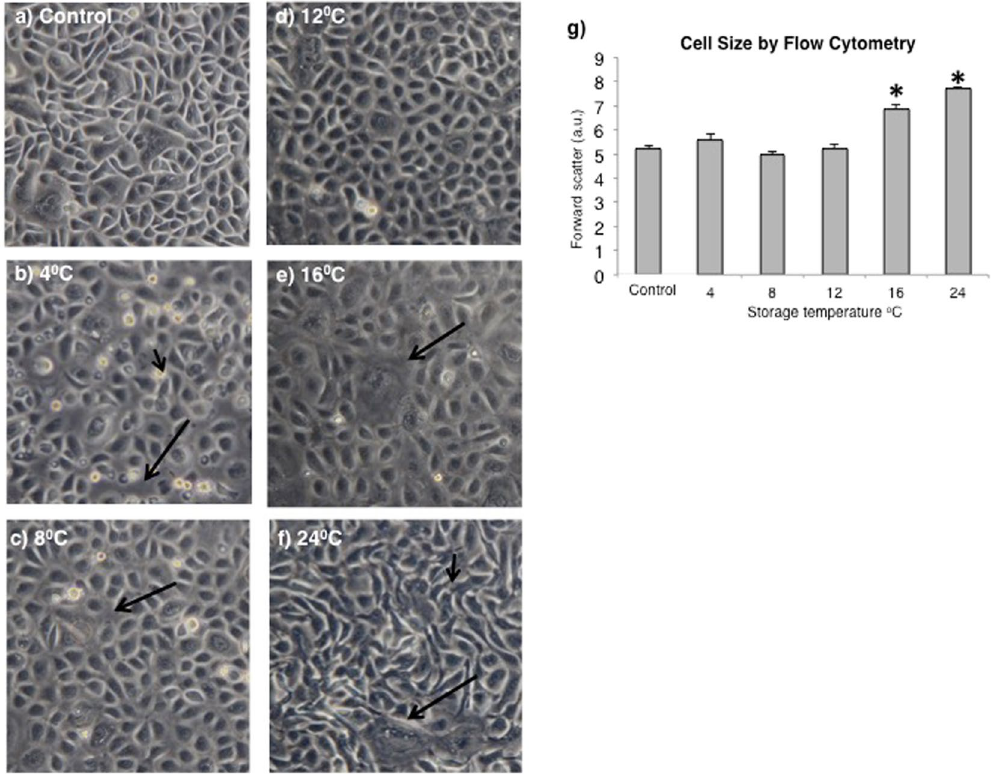
Figure 4. Cell morphology as shown by phase contrast (X200) micrographs. ( a ) Representative image of control. Gaps in the cell layer (arrows) were seen at 4 °C ( b ) and at 8 °C ( c ). Dead cells (arrowhead) were also present at 4 °C ( b ). The cell layer was similar to control at 12 °C ( d ). Large cells (arrows) were more frequent at 16 °C ( e ) and at 24 °C ( f ) Extended filopodia (arrowhead) were also seen at 24 °C ( g ) Cell size indicated by forward scatter by flow cytometry. ( * = significantly increased compared to control; p ≤